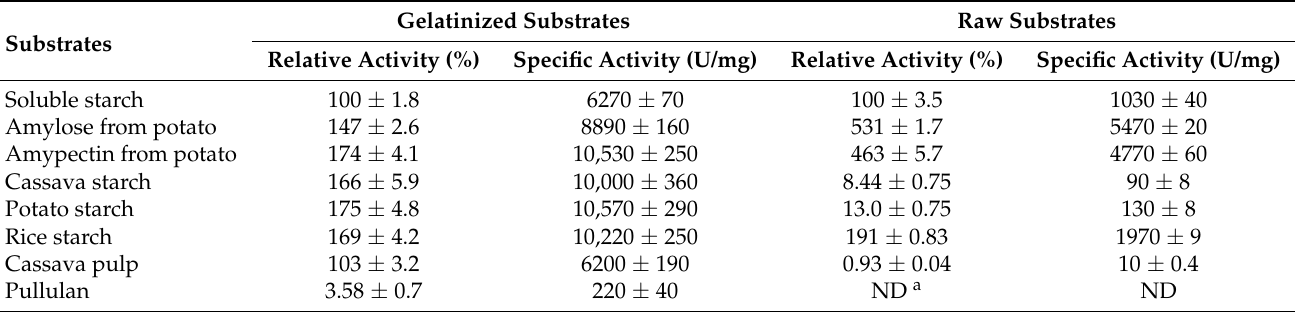
Table 1. Substrate specificity of HL11Amy against various gelatinized and raw substrates.